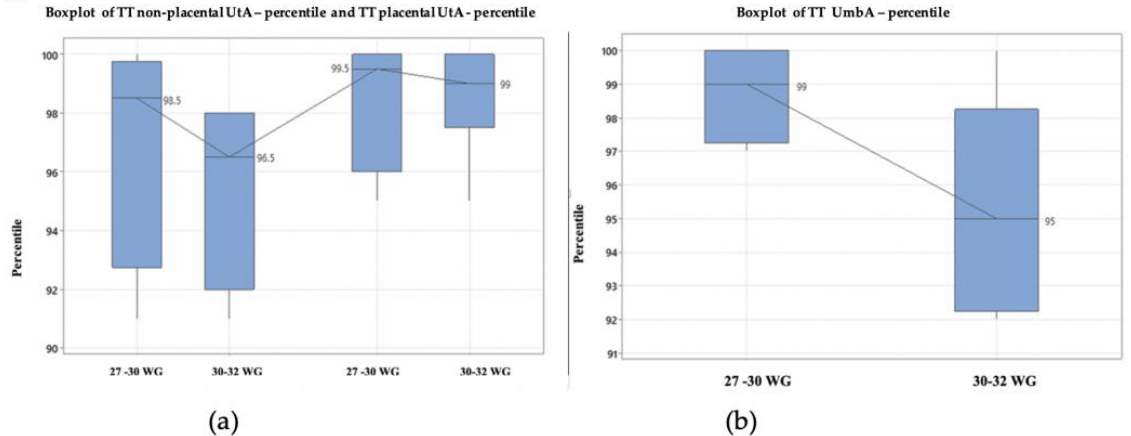
Figure 2. Doppler indices compared in the two subgroups: very early IUGR (requiring iatrogenic delivery between 27 and 29.6 weeks of gestation) and pregnancies which allowed continuing the pregnancy until 30–32 weeks of gestation. ( a ) The boxplot of placental and non-placental uterine artery assessed in the TT; ( b ) The boxplot of umbilical artery percentile. Abbreviations: TT third trimester, UtA uterine artery, WG weeks’ gestation, Umb A umbilical artery. Total prenatal visits in pregnancy and of TT visits revealed an increased number of medical visits in the very early suspected IUGR subgroup (Figure 3). Based on the Kruskal–Wallis test, the differences between medians are statistically significant ( p <